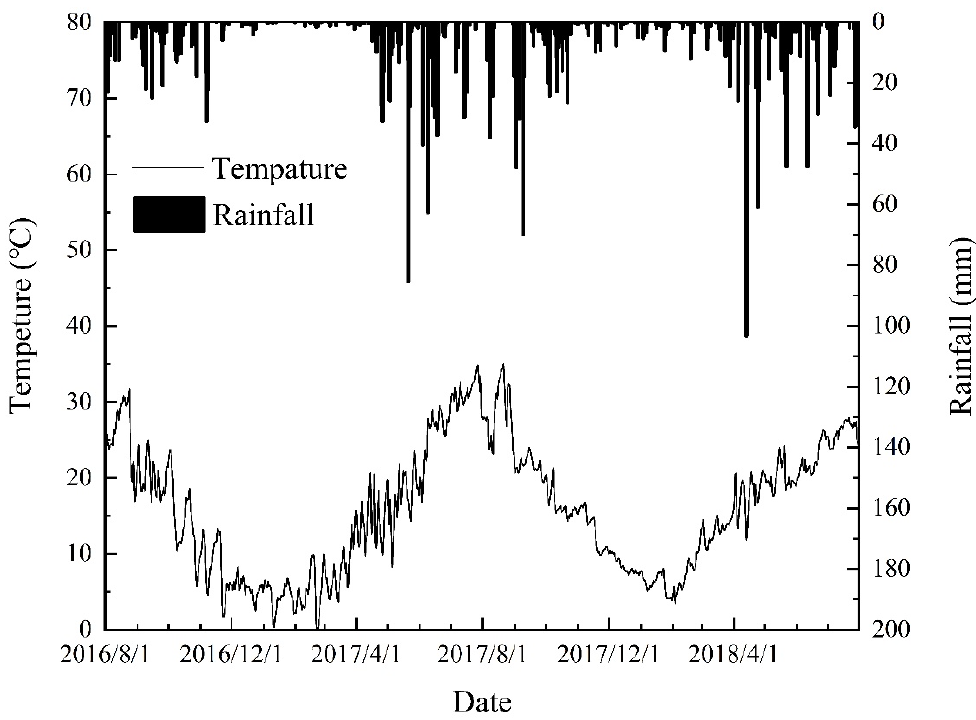
Figure 3. Rainfall and temperature from August 2016 to July 2018.